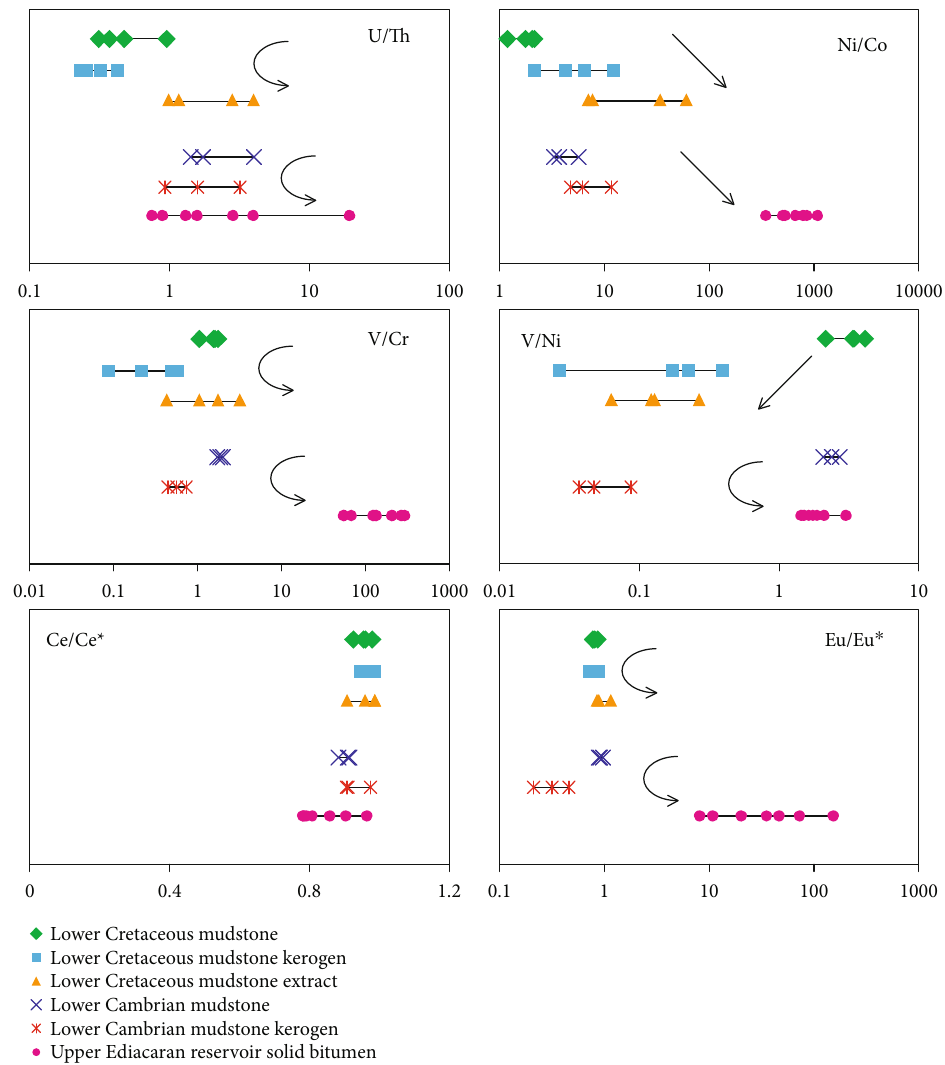
Figure 10: Diagram showing the comparison of redox-sensitive trace element ratios and REE parameters in the whole rock, kerogen, and extract/reservoir solid bitumen. Trace element ratios (e.g., Ni/Co, V/Cr, and V/Ni) show little variation in mudstone whole rocks, but they greatly changed in mudstone kerogens, re fl ecting the subtle variations of paleoredox environments during the sedimentation and early diagenesis of organic matter. U/Th, V/Cr, and V/Ni ratios show a decreasing trend between mudstone whole rock and kerogen, indicating that U and V may occur more in mineral phases of mudstone. Ni/Co ratios show an increasing trend between mudstone whole rock and kerogen, indicating that Ni may occur more in organic phases of mudstones. U/Th, Ni/Co, and V/Cr ratios display an increasing trend between mudstone kerogen and extract/reservoir bitumen, suggesting that redox-sensitive trace elements (U, Ni, and V) may be released from kerogens more easily than other elements. Slight di ff erences of Ce anomaly values occur among mudstone whole rock, kerogen, and extract/reservoir bitumen, whereas Eu anomalies in kerogens are more depleted than that in corresponding whole rocks, especially marine kerogens. The strongly negative Eu anomalies in kerogens might be representative of reducing environments during the sedimentation and early diagenesis of organic